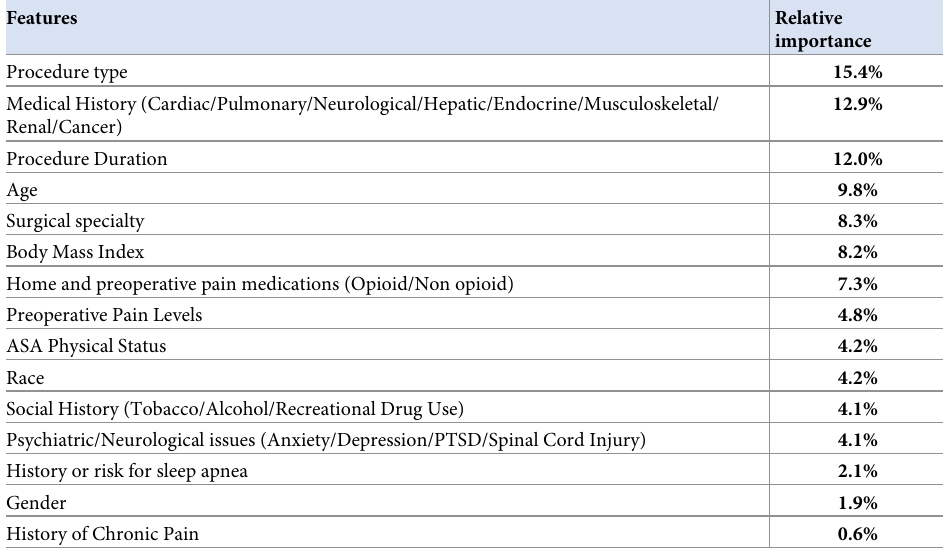
Table 8. Feature importance of Random Forest Model explaining the relative importance of various features con- tributing to predictions of opioid requirements. Similar features are consolidated.